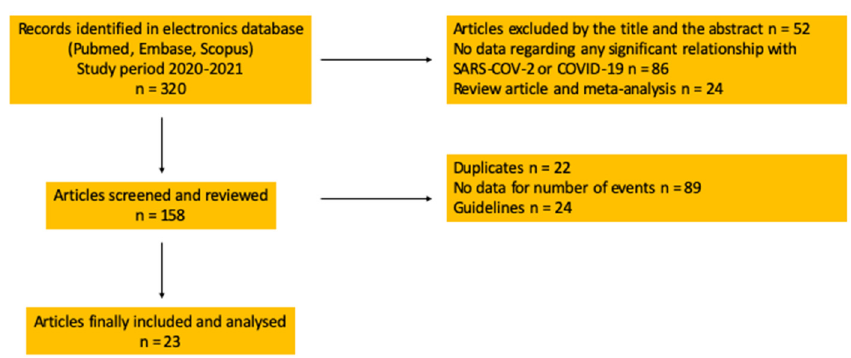
Figure 1. Study Figure 1. Study flow-chart.